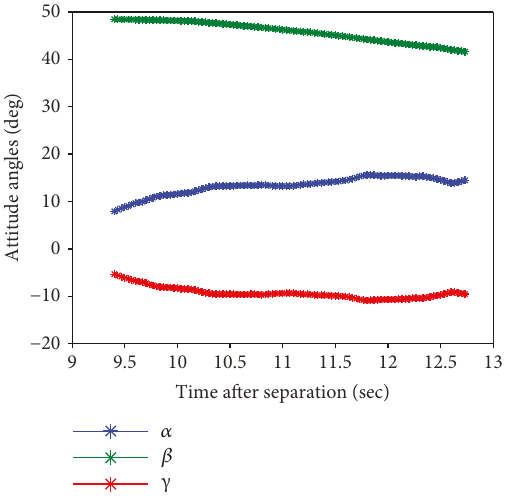
Figure 14: The attitude of the “ Chibis-M.